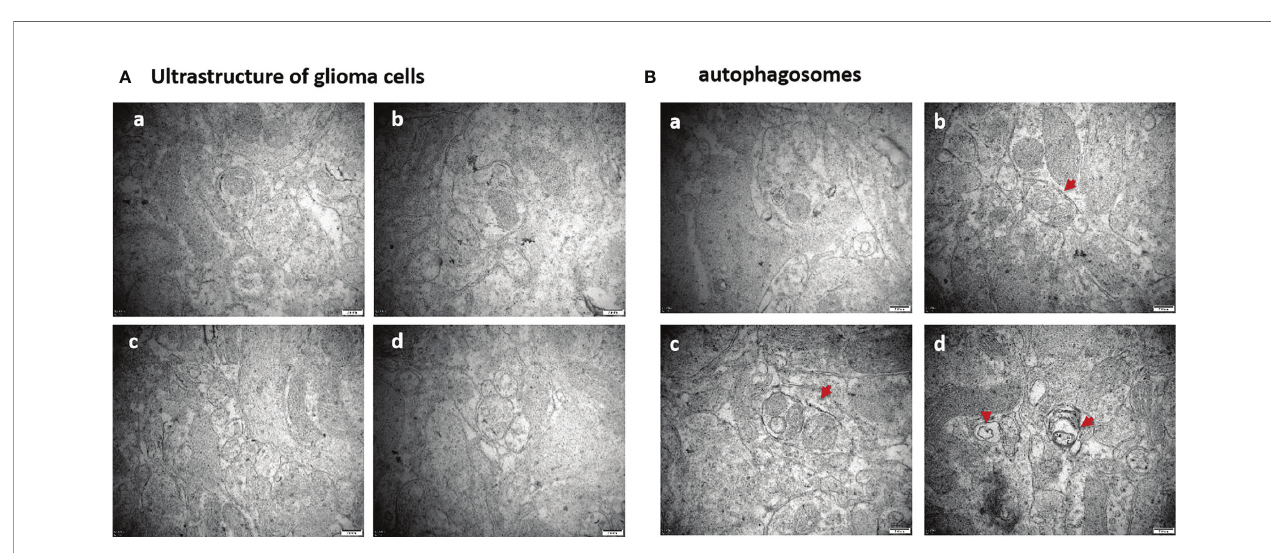
FIGURE 3 | (A) Ultrastructure of glioma tissues observed by transmission electron microscopy (×60000 times); (B) Observation of the formation of autophagosomes in glioma tissues by transmission electron microscopy (×60000 times). The red arrows are autophagosomes. (a) Control group (b) Borneol 16mg/Kg (c) Radiotherapy 15Gy group (d) Borneol 16mg/Kg combined radiotherapy 15Gy group.